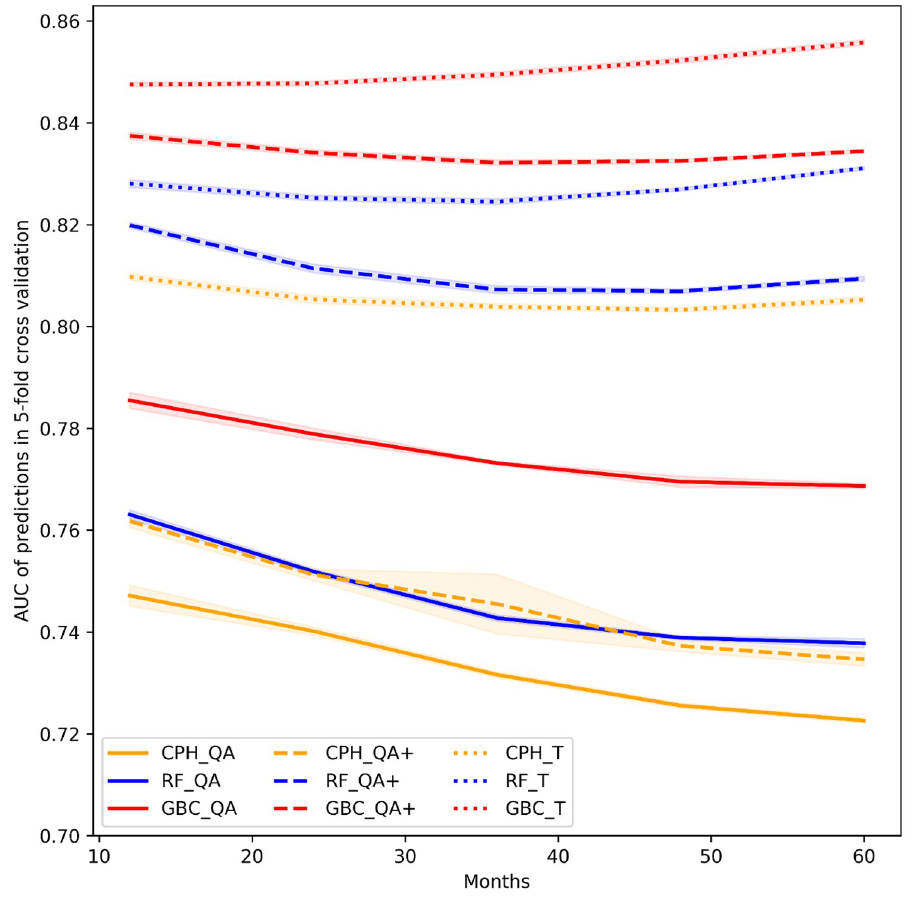
Fig 3. Model discrimination for different follow-up periods (from 12 to 60 months after baseline). Colours differentiate the 3 modelling techniques (GBC, RF, and CPH), whereas line styles indicate the predictor sets (QA, QA +, and T). AUC, area under the receiver operating characteristic curve; CPH, Cox proportional hazards; GBC, gradient boosting classifier; RF, random